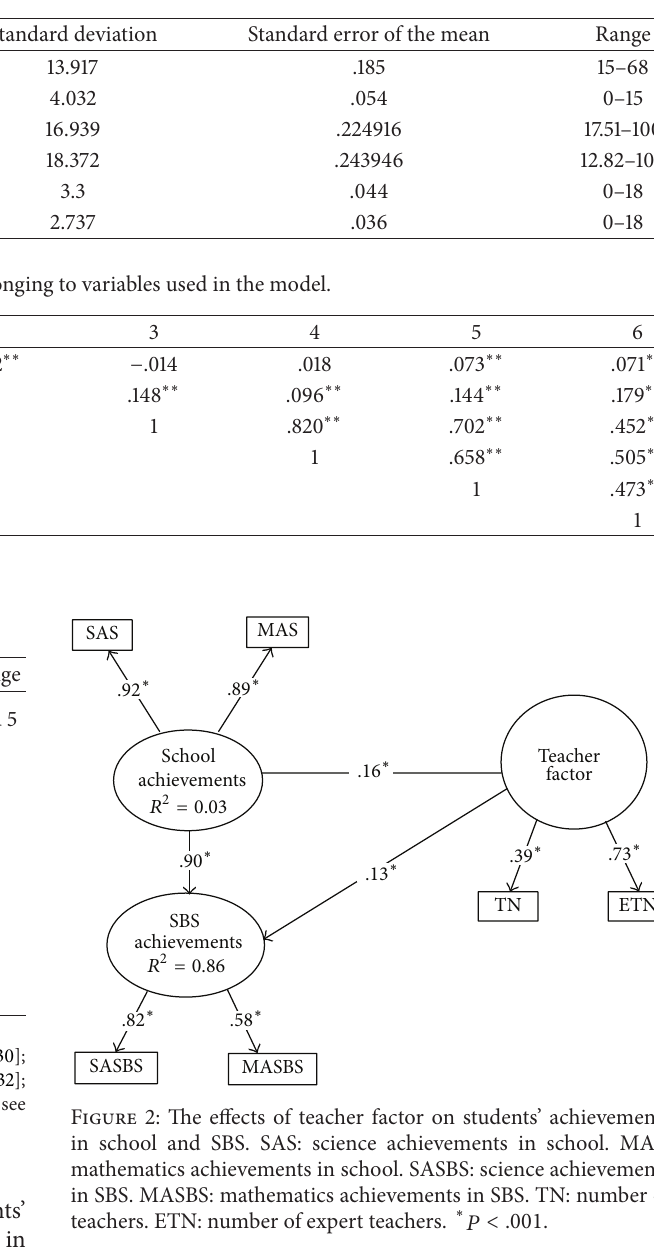
Table 2: Descriptive statistics of the variables used in the model.